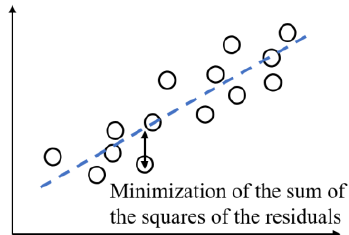
Figure 4. Multiple linear regression.